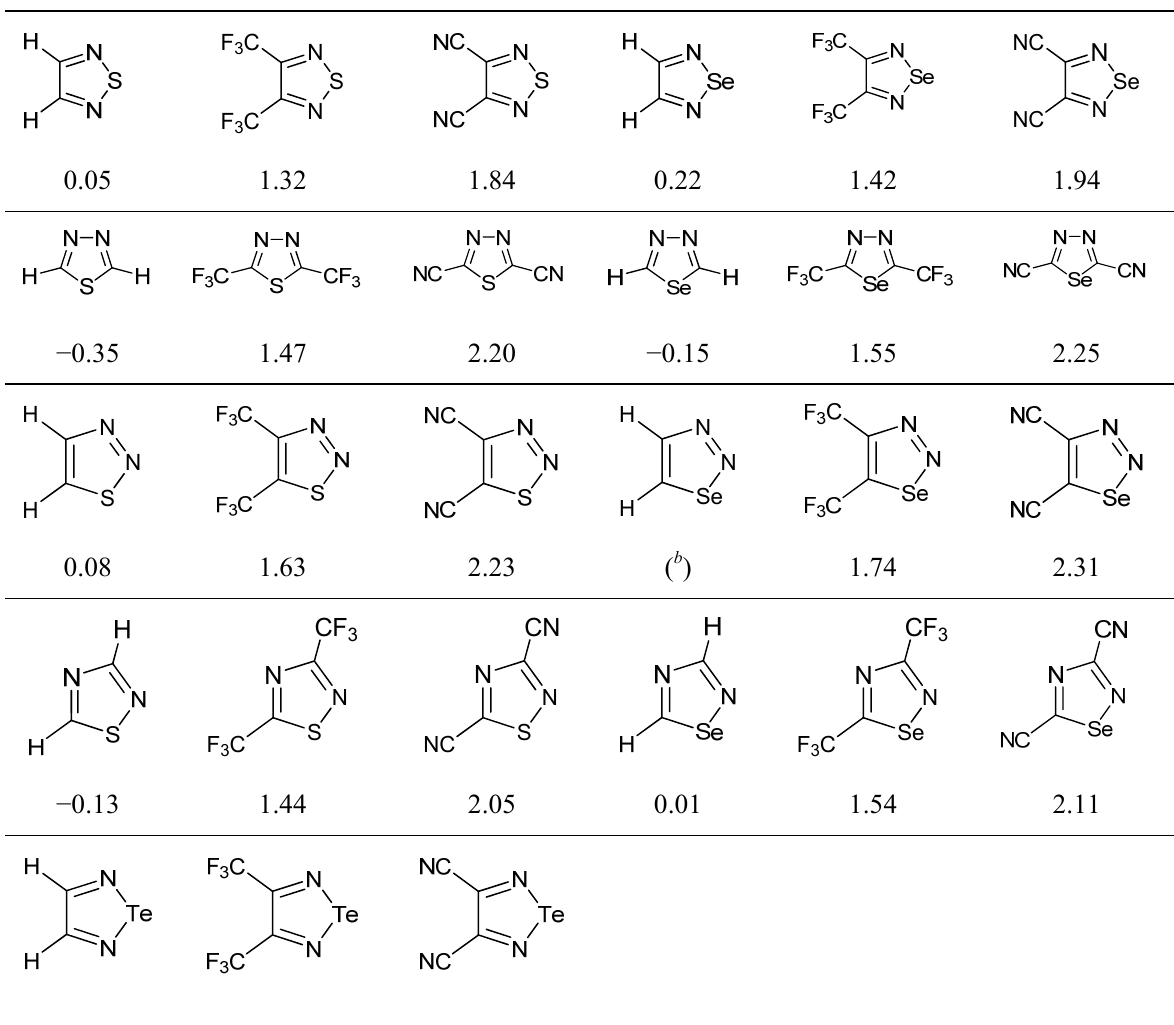
Table 2. (U)B3LYP/6-31+G(d) adiabatic EA (eV) of the archetypal 1,2,3-, 1,2,4-, 1,2,5- and 1,3,4-thiadiazoles, their Se and Te congeners and selected derivatives [72,88]. a